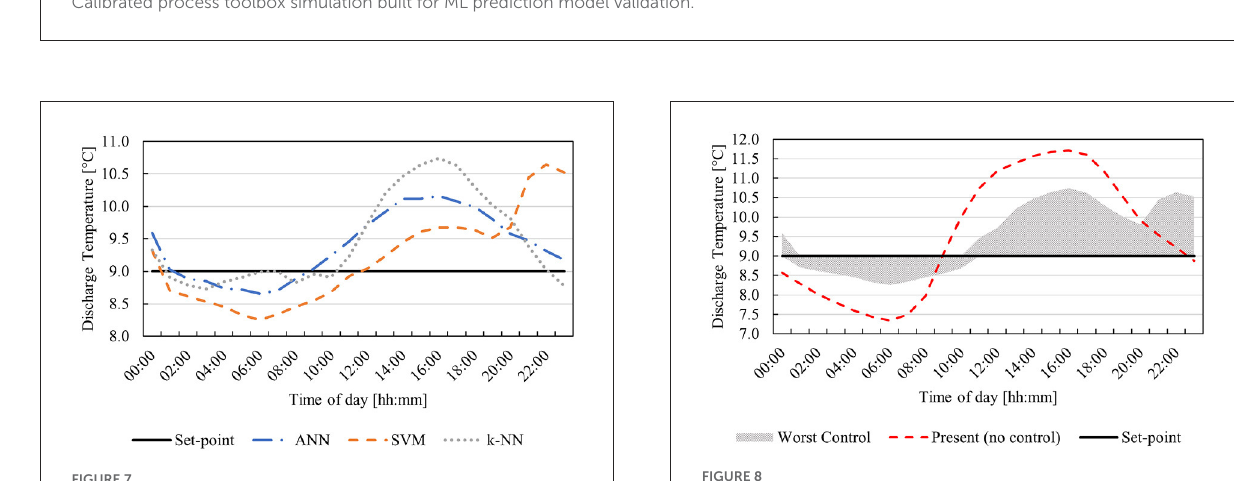
FIGURE7 Comparison of ML predictive models for an average day’s ambient conditions.